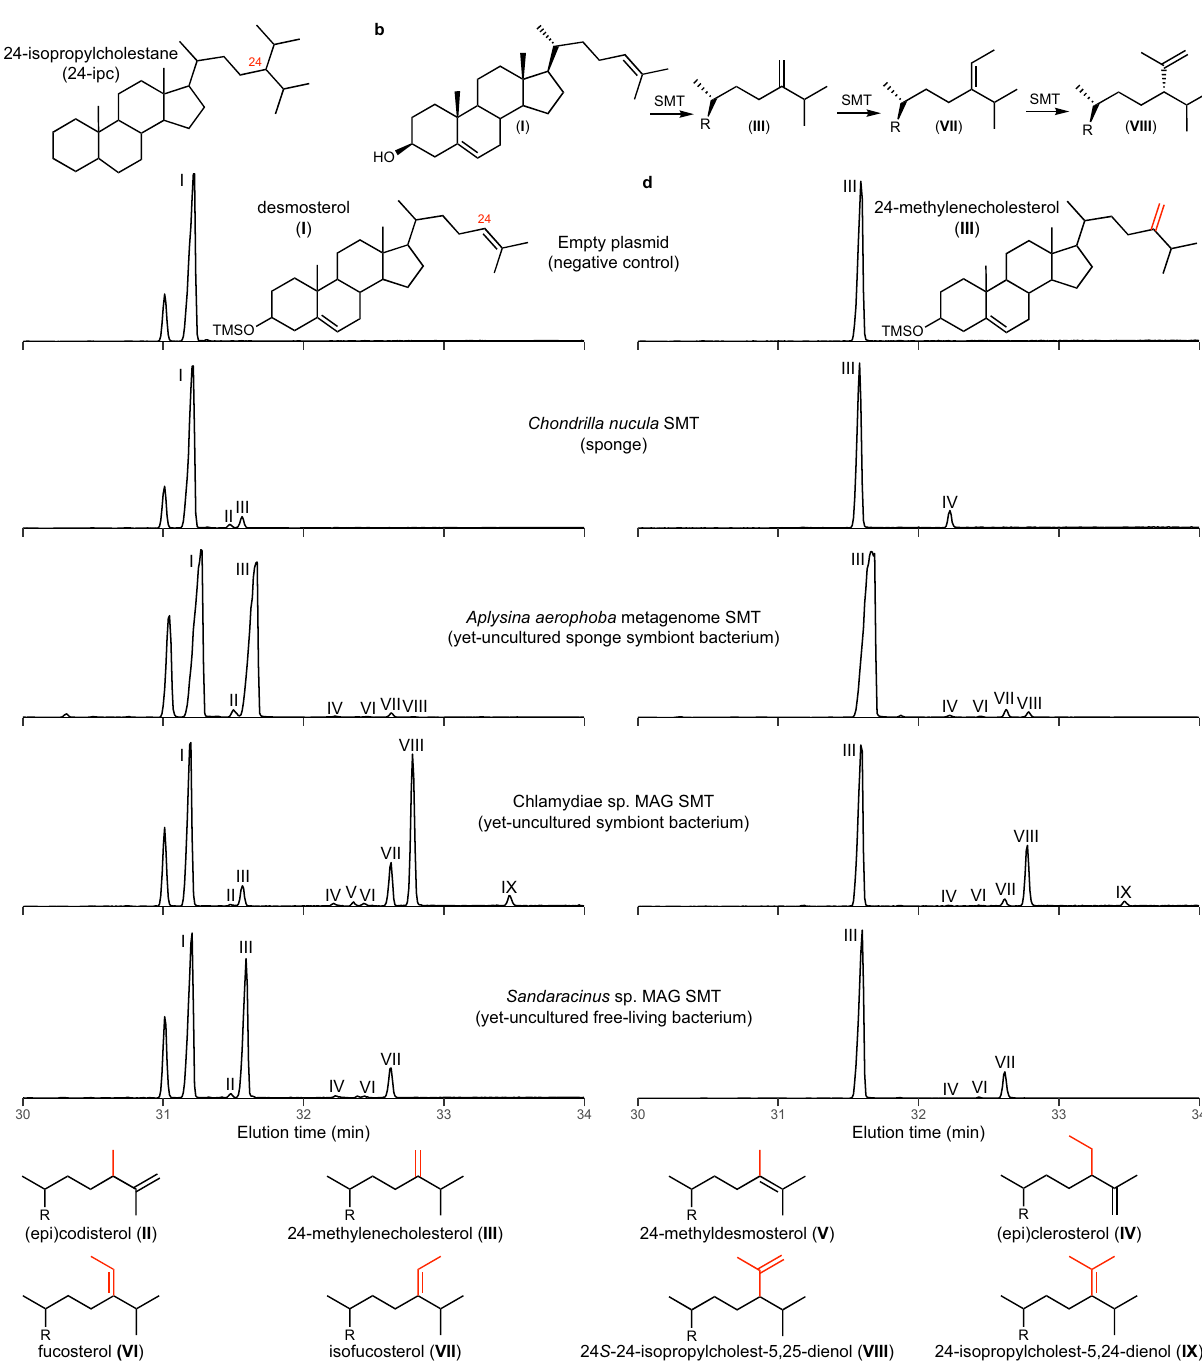
genome (MAG) assigned to the phylum Chlamydiae, and a myxobacterial SMT identi fi ed in a marine MAG assigned to the genus Sandaracinus . d Representative extracted ion chromatograms ( m/z 456, 470, 484, 498) of total lipid extracts from in vitro reactions performed with the same lysates but with 24- methylenecholesterol as the substrate. e Side-chain structures of sterols identi fi ed in c and d .AlllipidswerederivatizedtotrimethylsilylspriortoGC-MSanalysis.The raw data used to generate this fi gure are provided in Supplementary Data 2. Mass spectra of identi fi ed sterols are shown in Supplementary Fig.